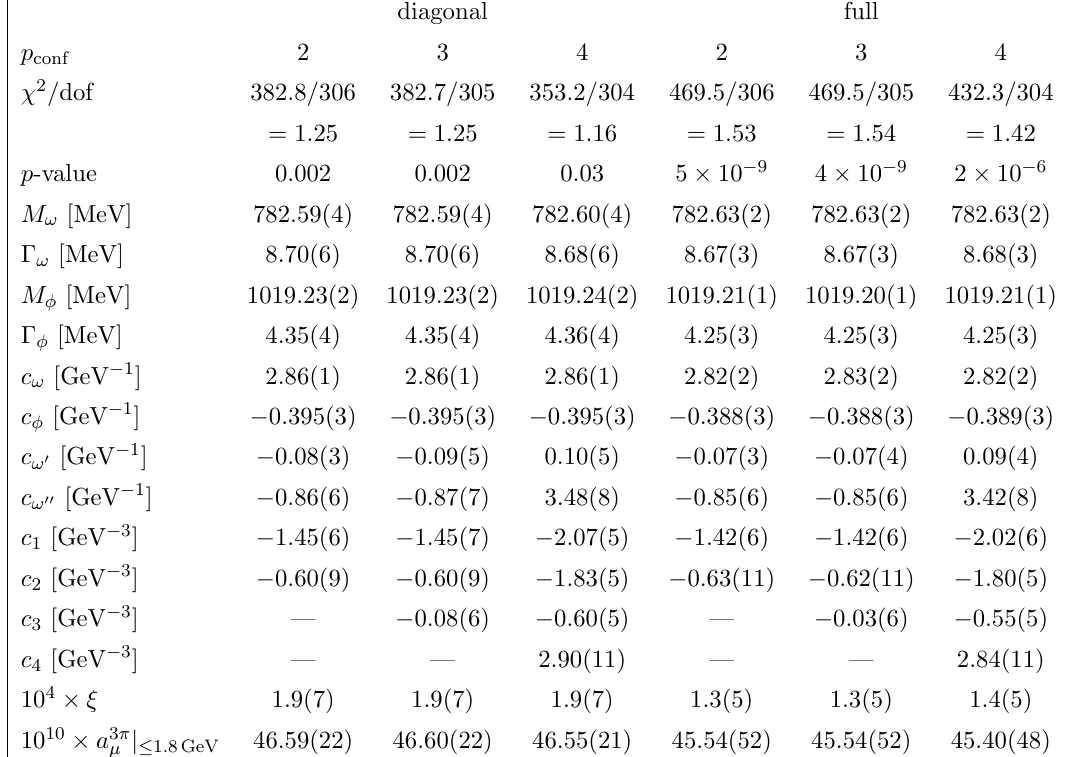
Table 8 . Same as table 6, but with Im C p ( q 2 ) almost the same central